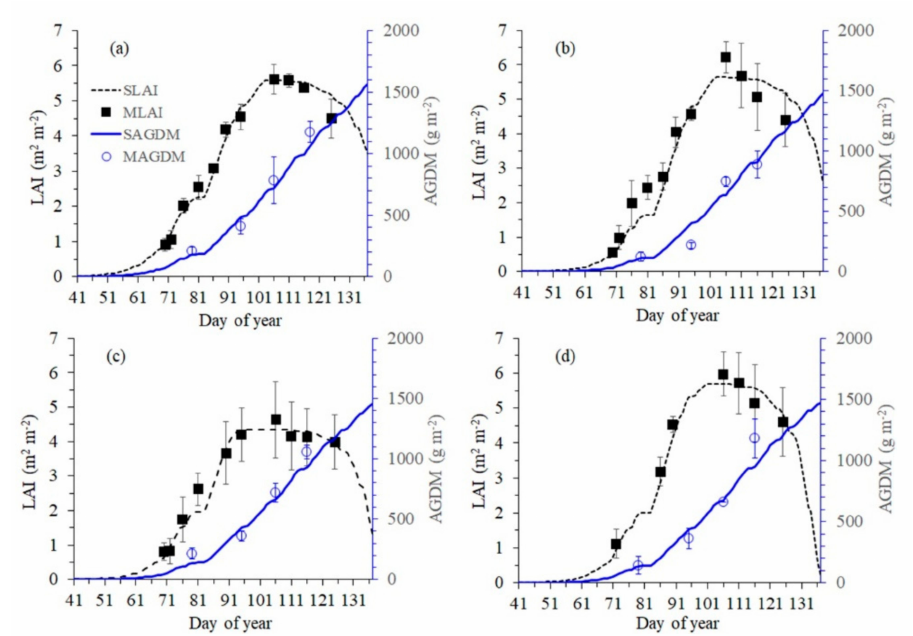
Figure 4. Simulated (S) versus measured (M) leaf area index (LAI) and above-ground dry mass (AGDM) for four barley cultivars ( a ) Black, ( b ) Heenchal, ( c ) Hopum, and ( d ) Saechal at Chonnam National University, Gwangju, South Korea in 2018 for model calibration. Vertical bars represent standard deviation of each mean value ( n = 3) at 95% confidence intervals.